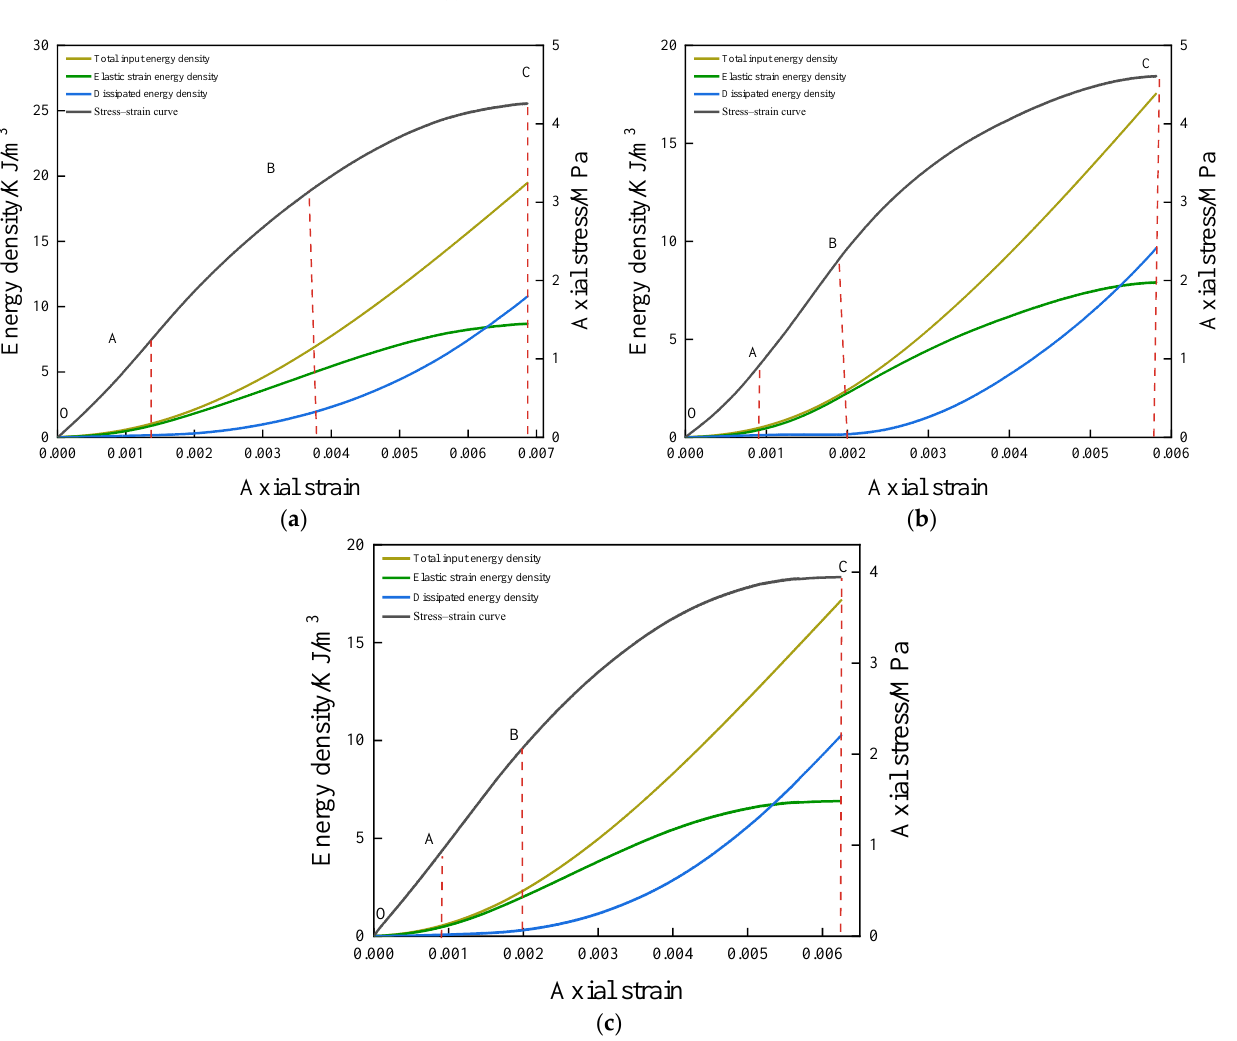
Figure 20. Prepeak energy density evolution characteristics of sandstone – CGFB composite samples. ( a ) C1; ( b ) C2; ( c ) C3.